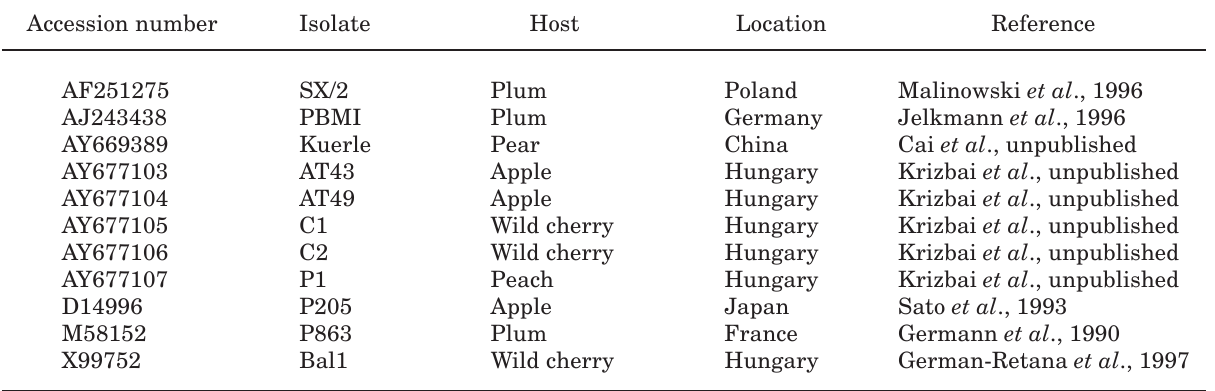
Table 2. Apple chlorotic leaf spot virus isolates referred to and described in other sources. Accession